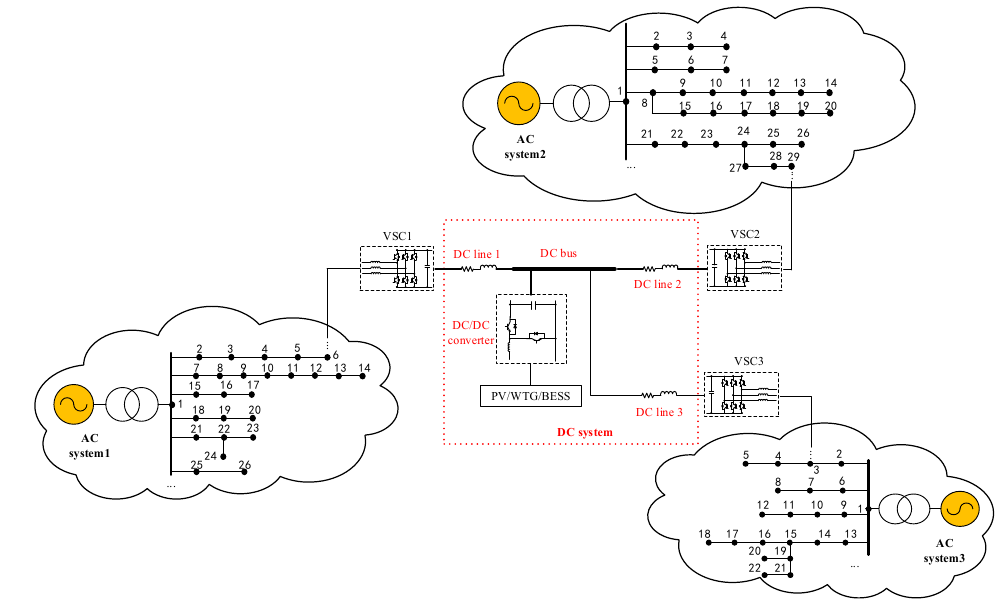
Figure 1. Structure of a low-voltage (LV) multi-terminal AC/DC hybrid system.